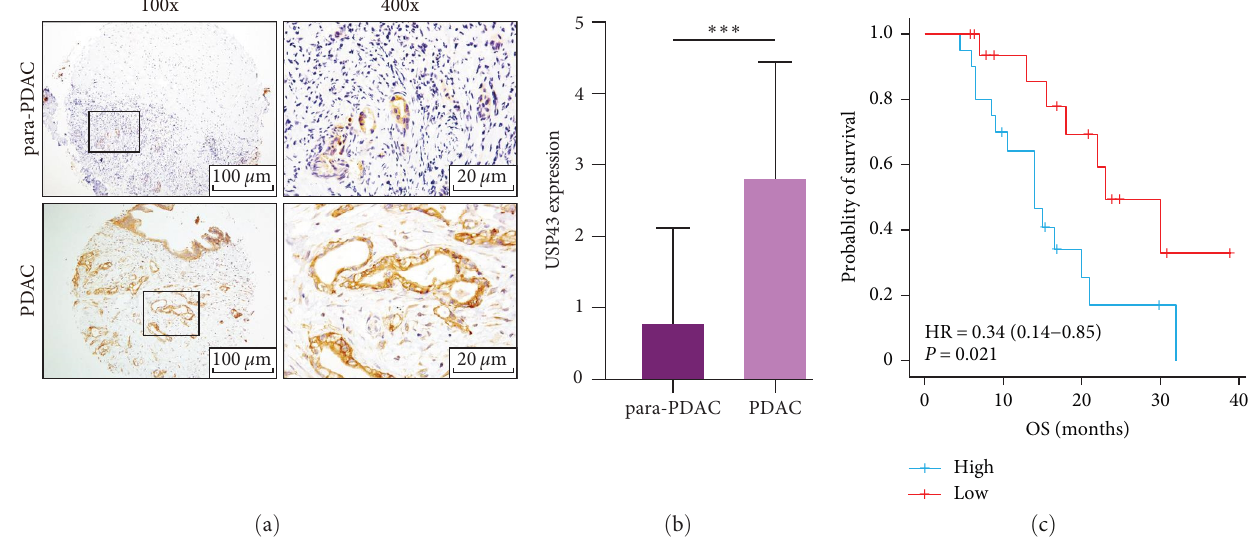
F IGURE 2: USP43 is highly expressed in PDAC and correlate with poor prognosis based on tissue microarray: (a) tissue microarray underwent IHC staining with USP43 antibody and we observe them with microscope ( × 100 and × 400); (b) after analyzed 38 patients ’ IHC staining, we analyzed the result with t -test; (c) survival curves of 38 patients with PDAC. Divide the patients according USP43 expression (high vs. low), then compare the OS of two group. ∗∗∗ P -values <